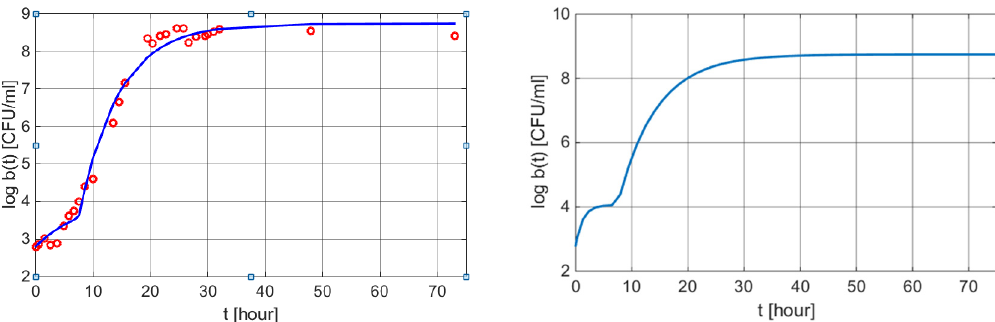
Figure 6. Graphical results of a weight loss profile obtained by using the mathematical models (6) and (9). Left: measured values vs. values obtained from Equation (15) with MATLAB function plot. Right: w(t) curve using the dynamic Simulink model (9) with the same parameters as in (15). Table 7. Values of the statistical indicators obtained using the data from [42]. Process The temporal evolution of the logarithmic number of Salmonella spp. per unit mL in TSB at 30 °C, pH 5.3, and aw 0.997